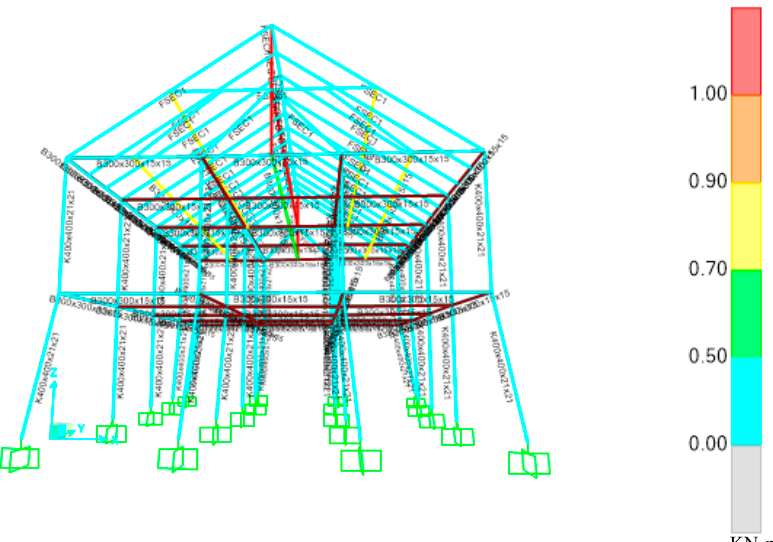
Figure 3. The structural load of an Ammatoan vernacular house. Buildings 2019 , 9 , 42